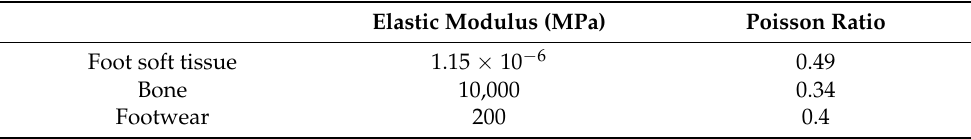
Figure 4. Nonlinear stress–strain response of soft tissue adopted for the FEA model [13]. Table 2. Details of the material properties [13] .